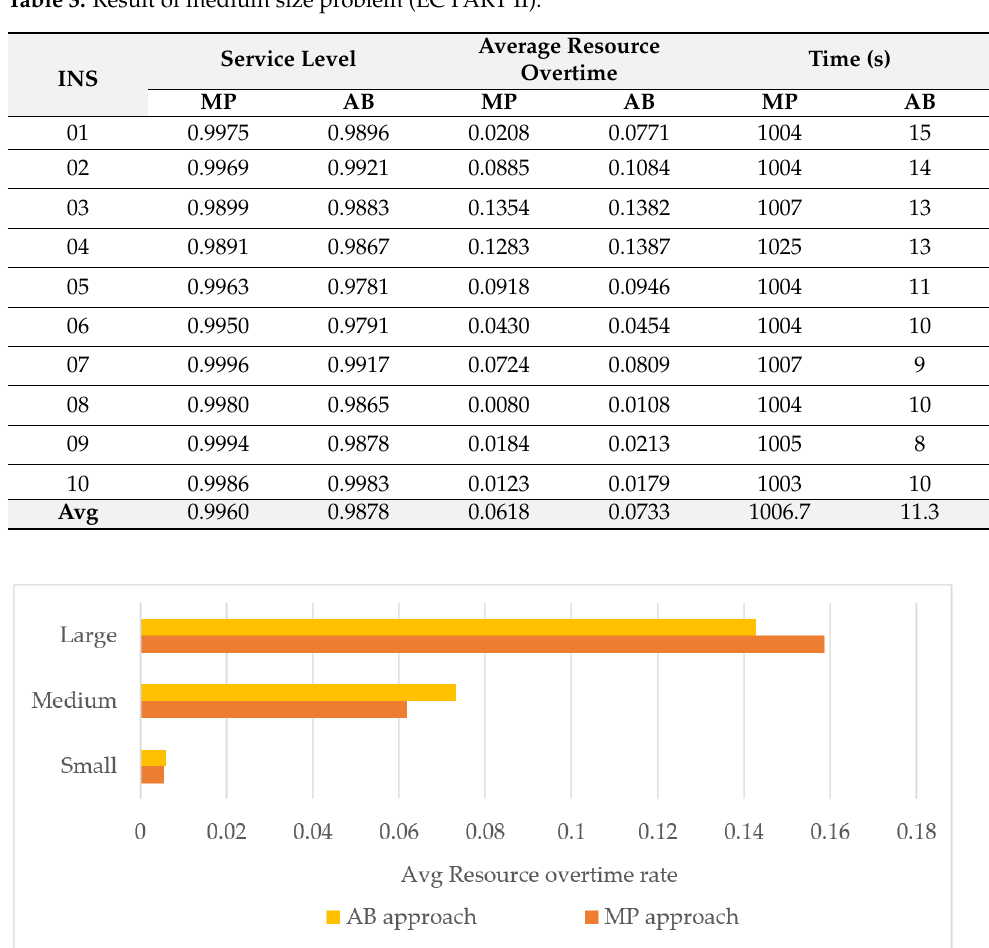
Figure 5. Average Resource overtime for small, medium, and large instances for MP and AP ap- proach.